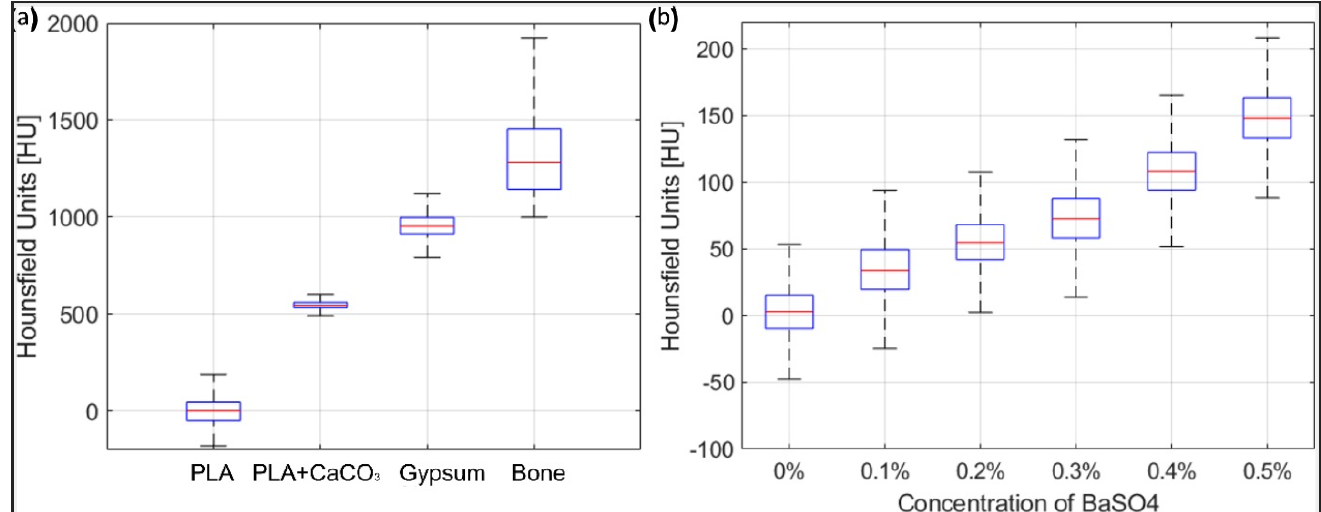
Figure 6. ( a ) Boxplots related to the X-ray attenuation, in Hounsfield units, of the materials for building the skull phantom. ( b ) Boxplots related to the X-ray attenuation, in Hounsfield units, of the mixtures for producing the brain.